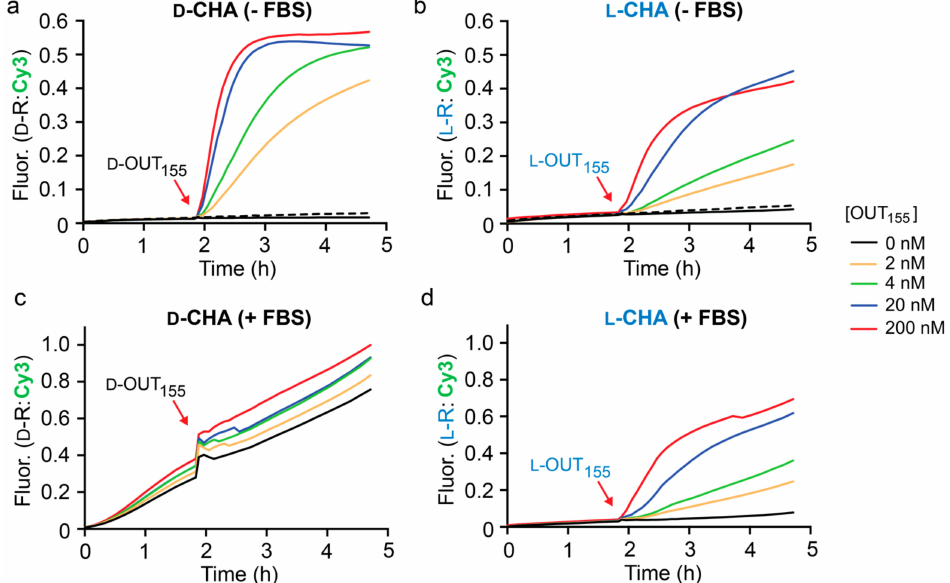
Figure 3. Fluorescence monitoring (Cy3) of CHA reactions in the absence ( a , b ) and presence ( c , d ) of 10% fetal bovine serum (FBS). All reaction mixtures contained 200 nM hairpins (H1 and H2) and 200 nM reporter complex (R) in the indicated stereochemistry, along with either 0% or 10% FBS, 50 mM KCl, 20 mM NaCl, 1 mM MgCl 2 , and 25 mM TRIS (pH 7.6). Reactions were initiated with the indicated concentration of either d - or l -OUT 155 and were carried out at 37 ◦ C. CHA reactions initiated with a scrambled input OUT s (200 nM) are indicated by dotted lines. Fluorescence (Fluor.) in all figures is reported in units such that 0.0 and 1.0 are the fluorescence of the quenched and activated reporter complex, respectively, at 200 nM. Average fluorescence data from triplicate experiments is